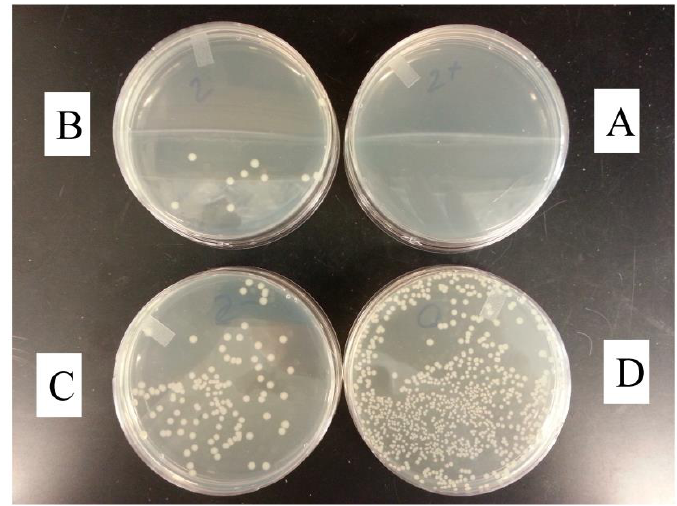
Figure 7. E. coli O157:H7 colonies on the surface of coated petri dishes after washing. Each petri dish coated with 10 mL zein formulations. ( A ) Sample #2 + : bilayered film, 8 mL neat zein in bottom and 2 mL TiO 2 /zein (2%) on top (under light for 15 h and then in dark for 3 h); ( B ) Sample #2: TiO 2 /zein (2%, under light for 15 h and then in dark for 3 h); ( C ) Sample #2 − : TiO 2 /zein (2%, under light for 3 h and then in dark for 15 h); ( D ) Sample #0: coating with neat zein (under light for 15 h and then in dark for 3 h).